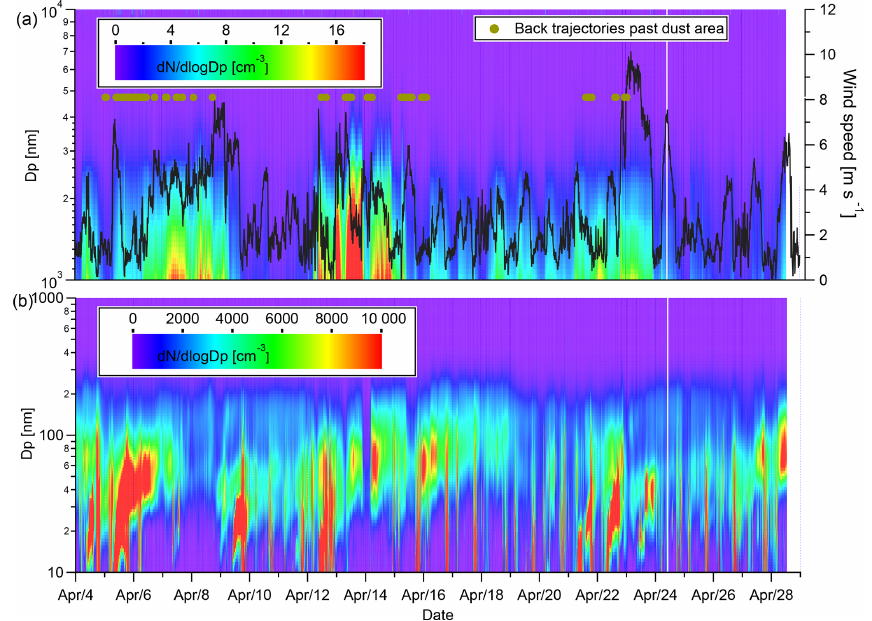
Figure 4. Contour plots for PNSDs during the whole campaign. The color scale indicates d N/ dlog Dp in cm − 3 . (a) Contour plots for PNSDs of 1000 to 10000nm. Black line shows time series of wind speed and the brown dots show the time when backward trajectories passed the dust area. (b) Contour plots for PNSDs of 10 to 1000nm.